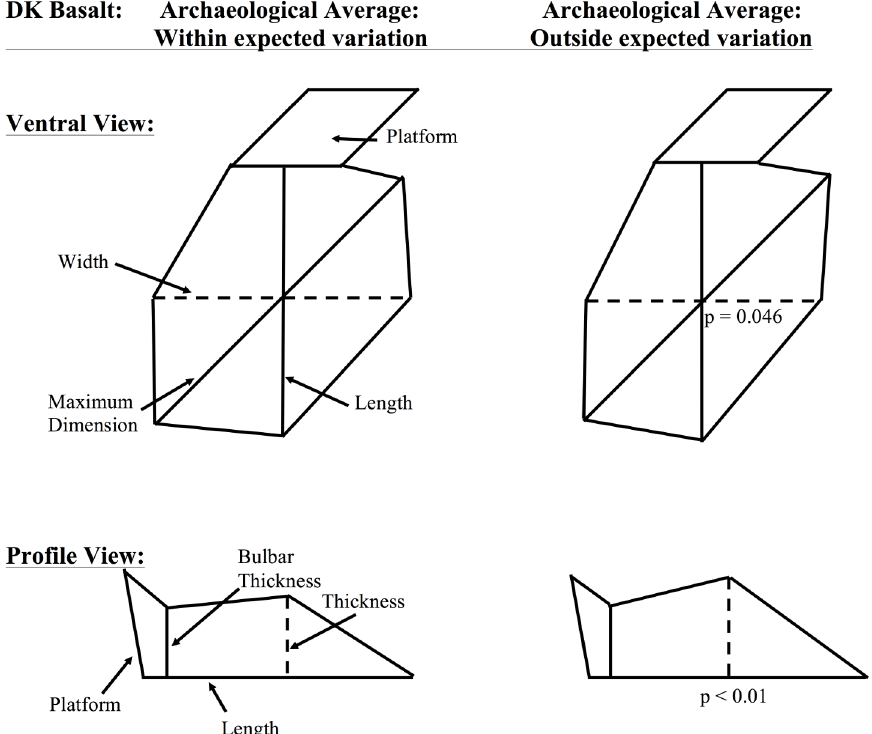
Fig 6. Schematic images of average basalt flakes from DK, Olduvai Gorge falling within and outside of expected variation. These images represent idealized, schematic images of average measurements for Olduvai Gorge archaeological flakes from the site of DK that are made from basalt. The first column shows the ventral and profile views of the average DK flakes that fall within experimentally expected variation. The second column shows the ventral and profile views of the average DK flakes that fall outside of experimentally expected variation. For consistency and ease of comparison, the maximum dimension was placed at a 45-degree angle from the length measurement. All measurements are still size standardized, but are translated into inch units, such that if the average size-standardized length measurement is 1.0, this becomes 1.0 inch in this image. Similarly, average platform area is depicted as a square, such that platform width and thickness are equal and both are the square root of average platform area. Significant differences between outside-of-range and within-range assemblages are dotted lines, p-values are